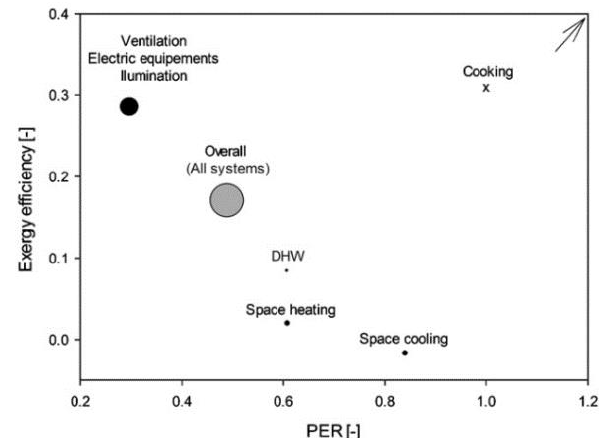
Figure 6. Exergy efficiency versus Primary Energy Ratio (PER) for single end uses in a four-star hotel [24].